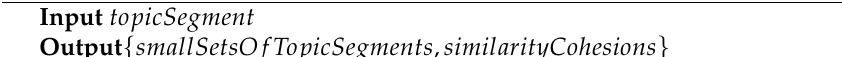
Algorithm A3 getSmallSetsO f TopicSegments . Input